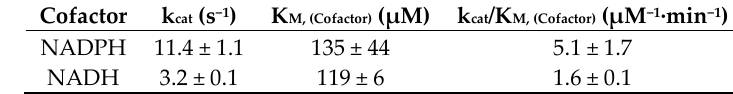
Figure 4. Michaelis-Menten curves for determination of cofactor preference: ◆ 0.5 M D -xylose, variation of NADPH; ▲ 0.5 M D -xylose, variation of NADH. Measurements were taken at 30 °C. Table 3. Cofactor preference of the investigated xylose reductase. Measurements were taken at 30 °C.